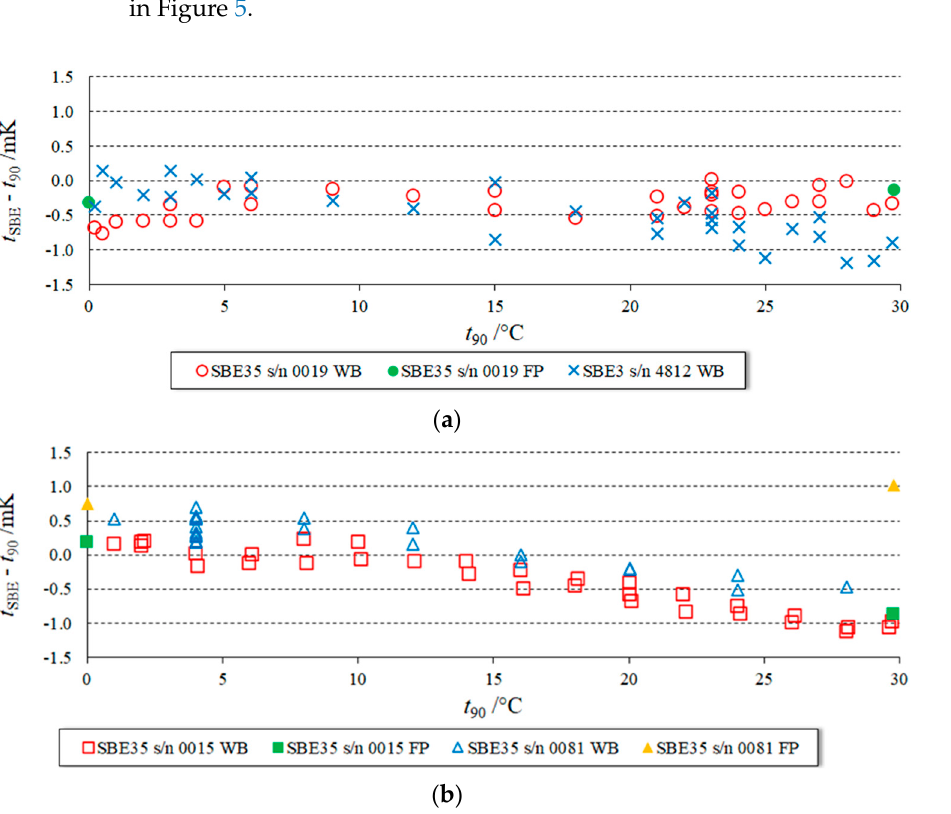
Figure 5. Recalibration of SBE35 and SBE3 units in a water bath (WB) — ( a ) SBE35 s/n 0019 and SBE3 s/n 4812 and ( b ) SBE35 s/n 0015, SBE35 s/n 0081. For convenience, the average of the SBE-35 fixed-point (FP) calibrations (TPW and Ga) are also reported in full symbols (full circle for SBE35 s/n 0019, full square for SBE35 s/n 0015, and full triangle for SBE35 s/n 0081).